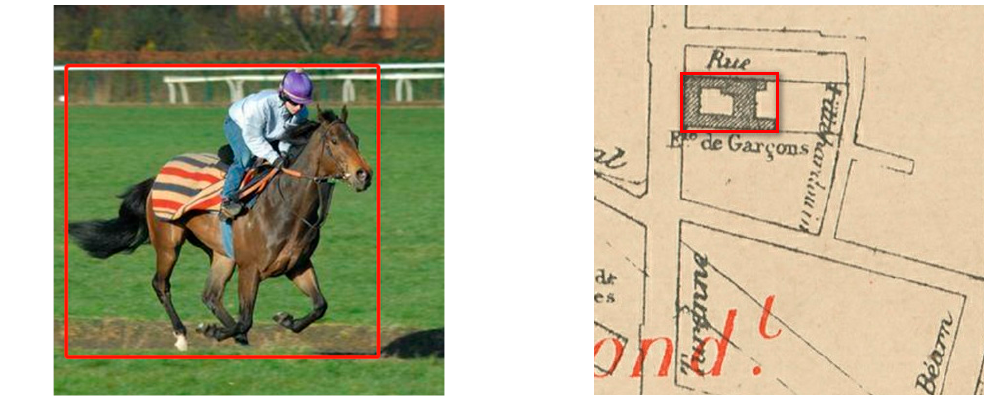
Figure 2. Comparison of object contexts. Rider on a horse in a natural image ( left ) and a building in a cropped historical map ( right ). The building block image represents only a small part of this theoretical map image compared to the natural image (area surrounded by red boxes as a proportion of the total image area).